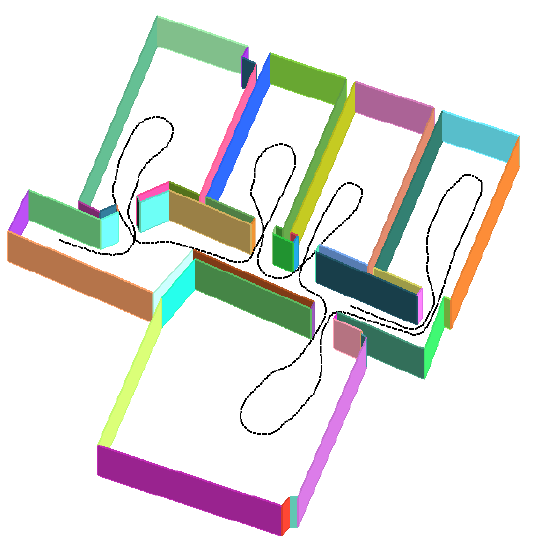
Figure 6. Model with walls of an office environment obtained by digitizing a floor plan together with a simulated sensor path.